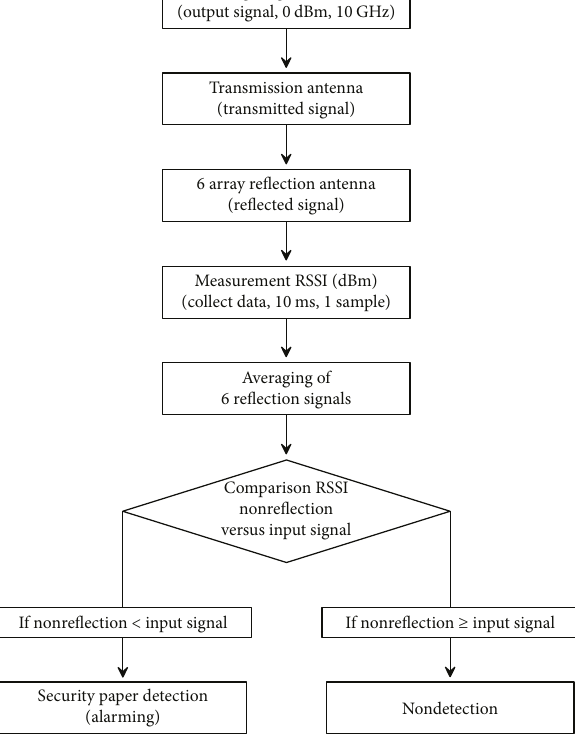
Figure 4: Algorithm of security paper